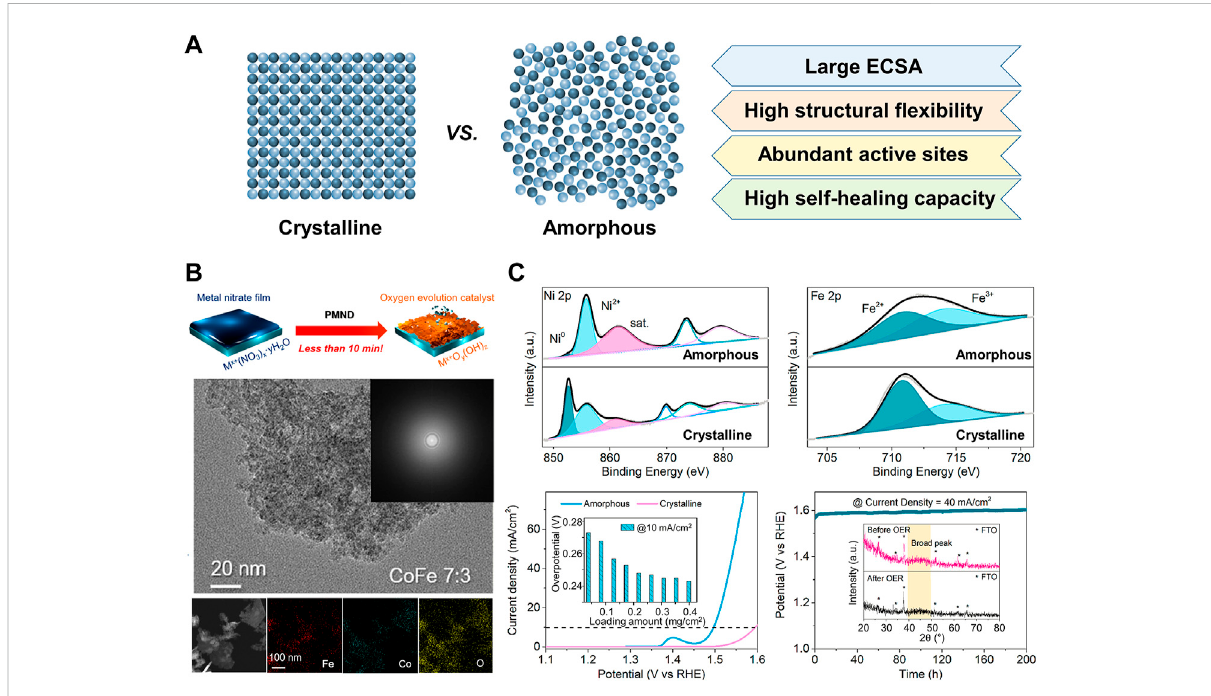
FIGURE 1 (A) Advantages of amorphous electrocatalysts compared to crystalline counterparts in OER (B) Precipitating metal nitrate deposition synthesis ofamorphousmetaloxyhydroxidesandTEMofCoFeoxyhydroxide,reproducedwithpermissionfromKimetal.(2019) (C) Surfacevalencestatesand electrocatalytic performance of amorphous NiFe alloy, reproduced with permission from Cai et al.